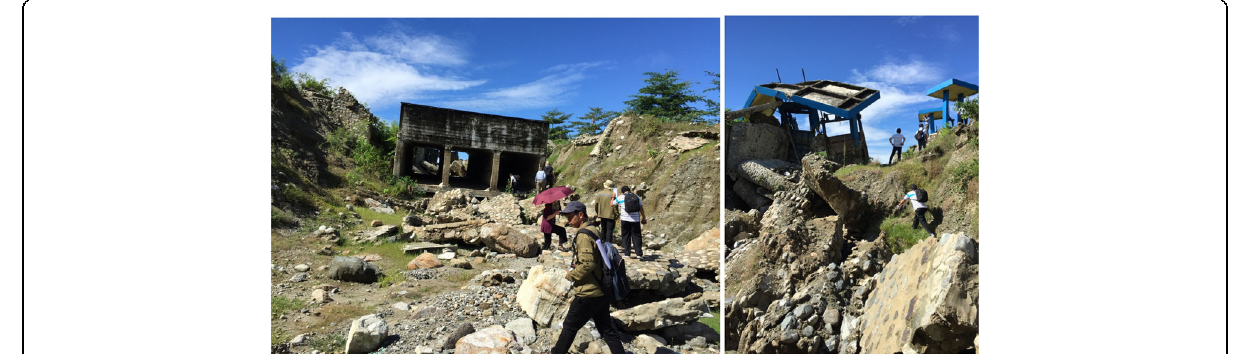
Fig. 1 Highly damaged irrigation channel in Sibalaya